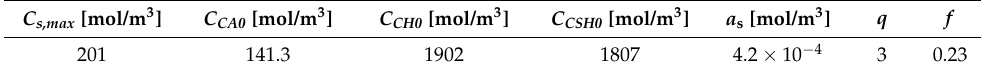
Table 3. Parameters obtained from the experimental data of Rozière et al. [75].